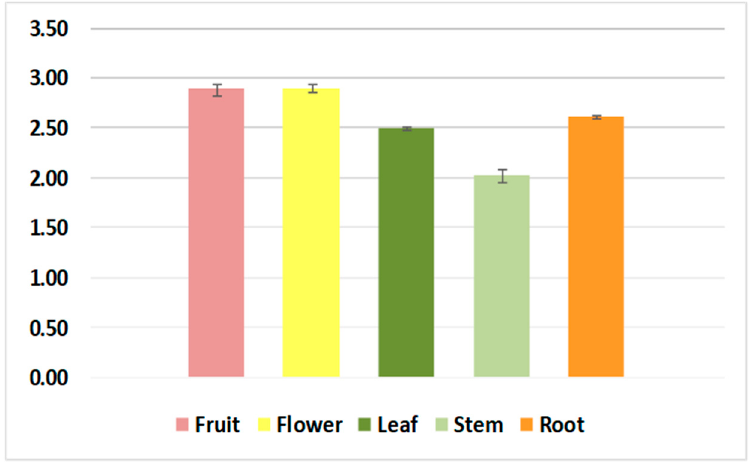
Figure 3. Antioxidant activity index (AAI) of the methanolic N. alba fruit, flower, leaf, stem, and root extracts.